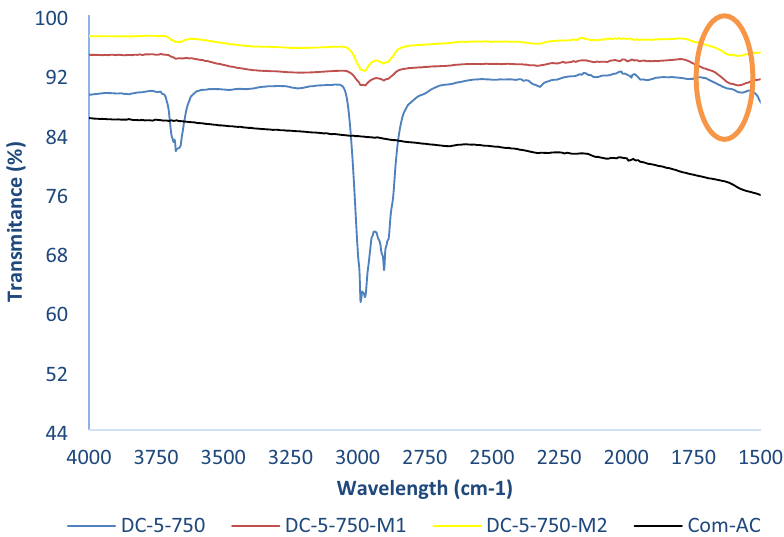
Figure 10. FT-IR spectra of Com-AC, DC-5-750 and its two derived oxidized sorbents.